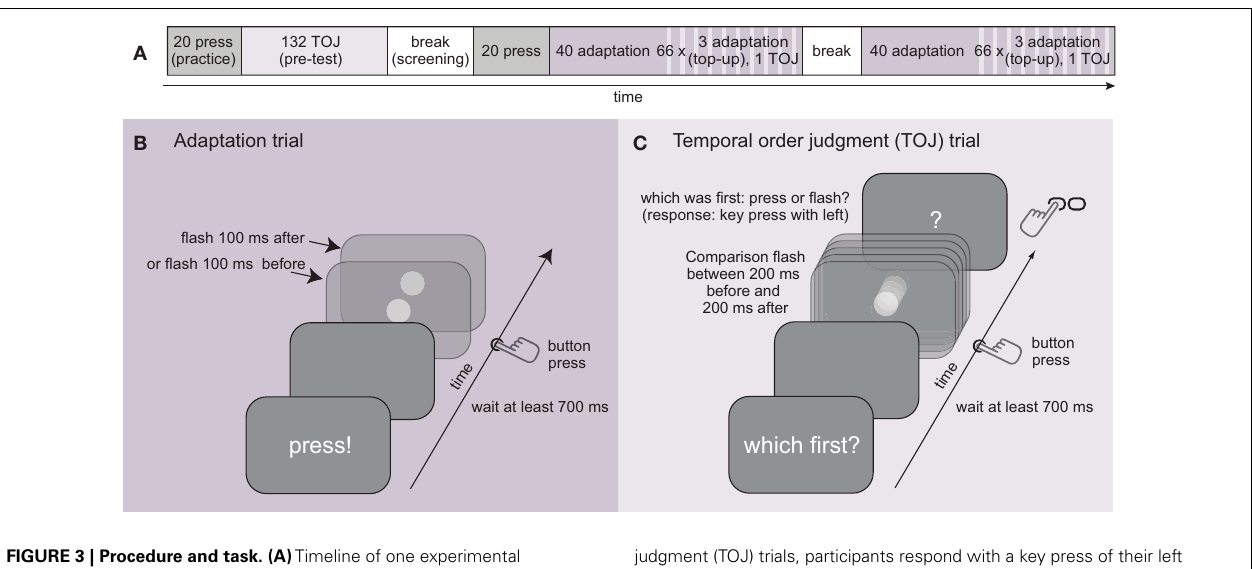
FIGURE 3 | Procedure and task. (A) Timeline of one experimental session. (B) In adaptation trials, participants are presented with either a vision-lead or movement-lead 100ms discrepancy. (C) In temporal order